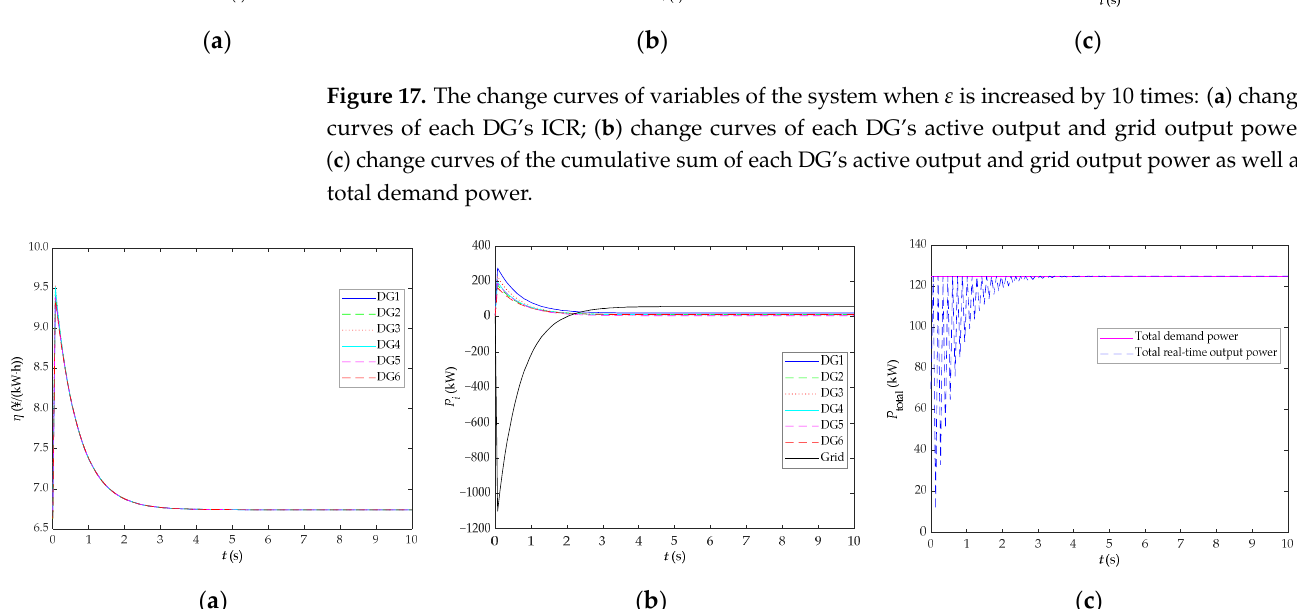
Figure 18. The change curves of variables of the system when ε is increased by 100 times: ( a ) change curves of each DG’s ICR; ( b ) change curves of each DG’s active output and grid output power; ( c ) change curves of the cumulative sum of each DG’s active output and grid output power as well as total demand power.